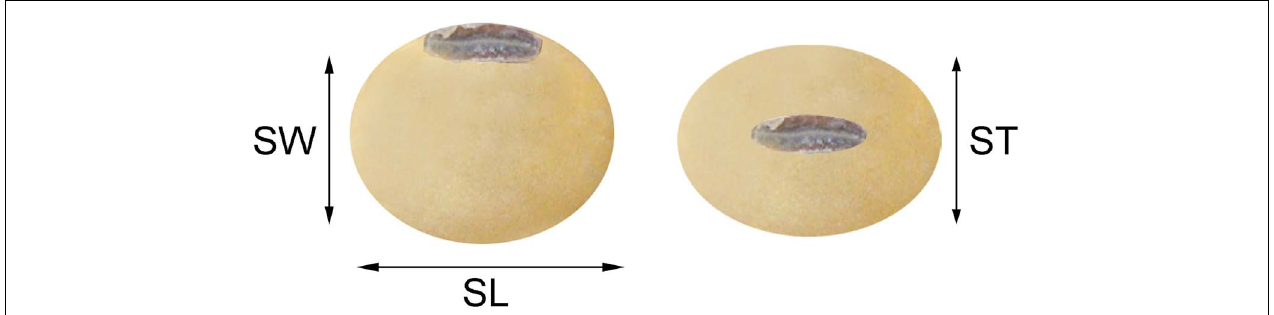
FIGURE 1 | Measuring seed width (SW), length (SL), and thickness